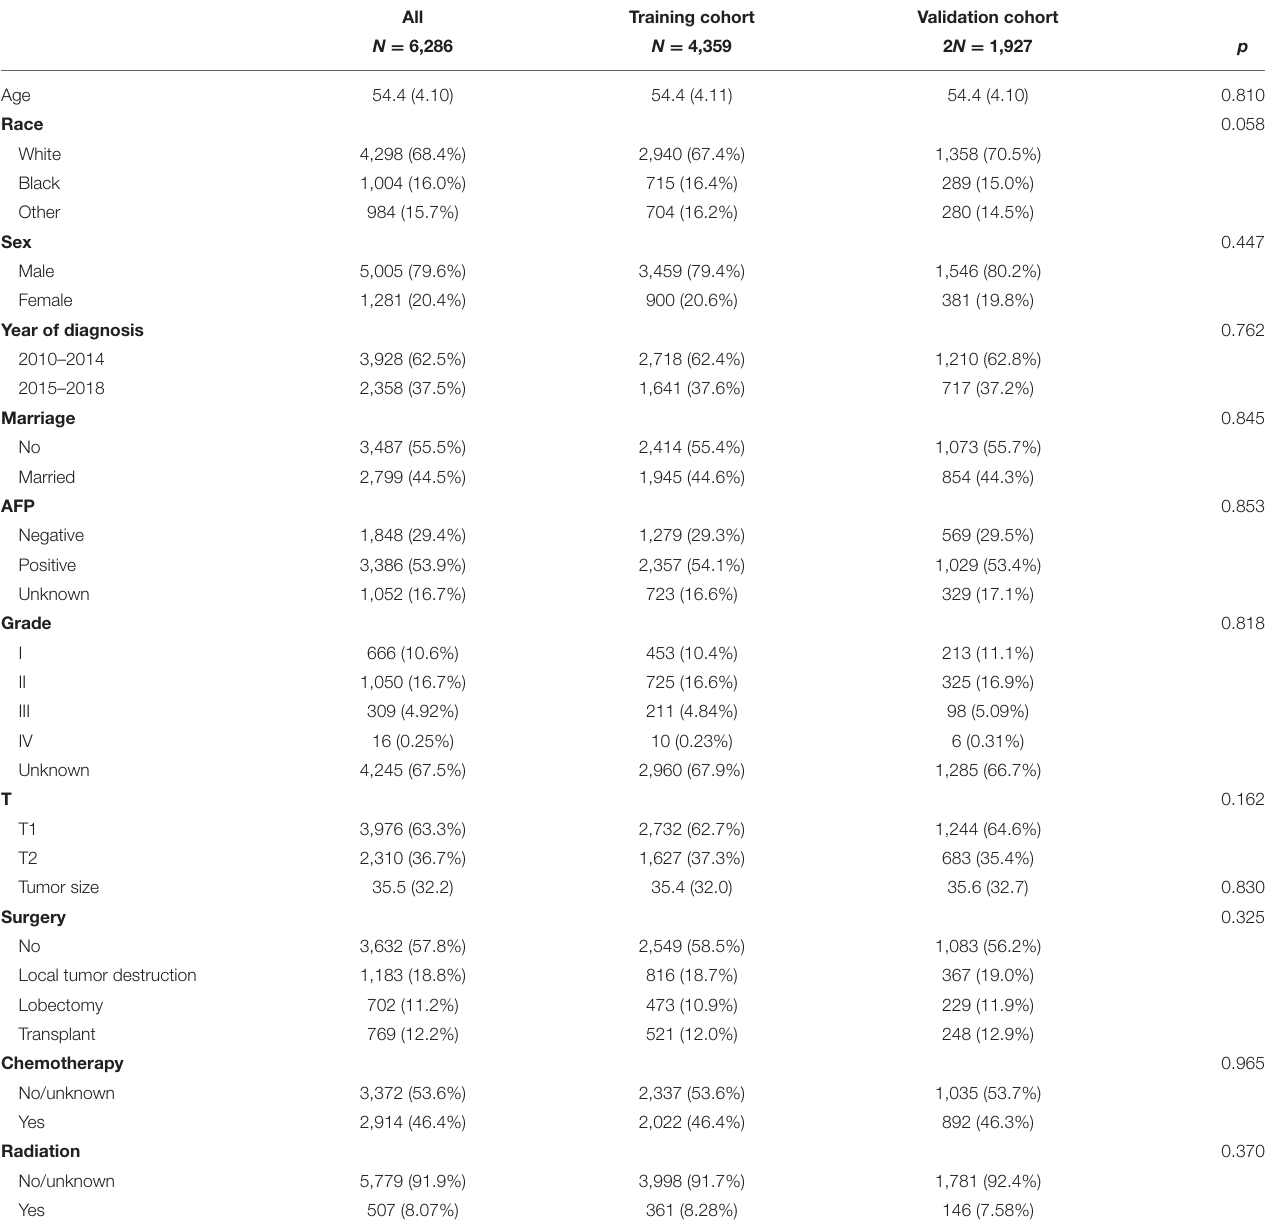
TABLE 1 | Clinicopathological characteristics of patients with